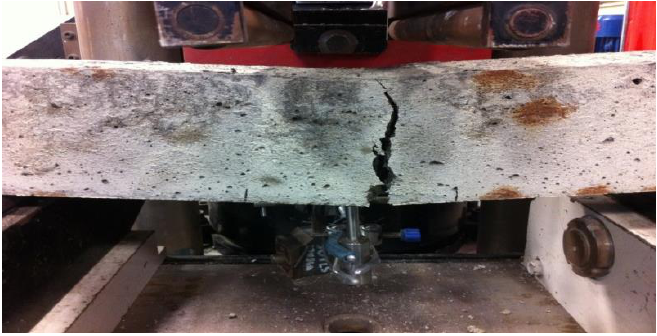
Figure 19. The failure mode of the concrete beam reinforced with 1.08% short fibres.